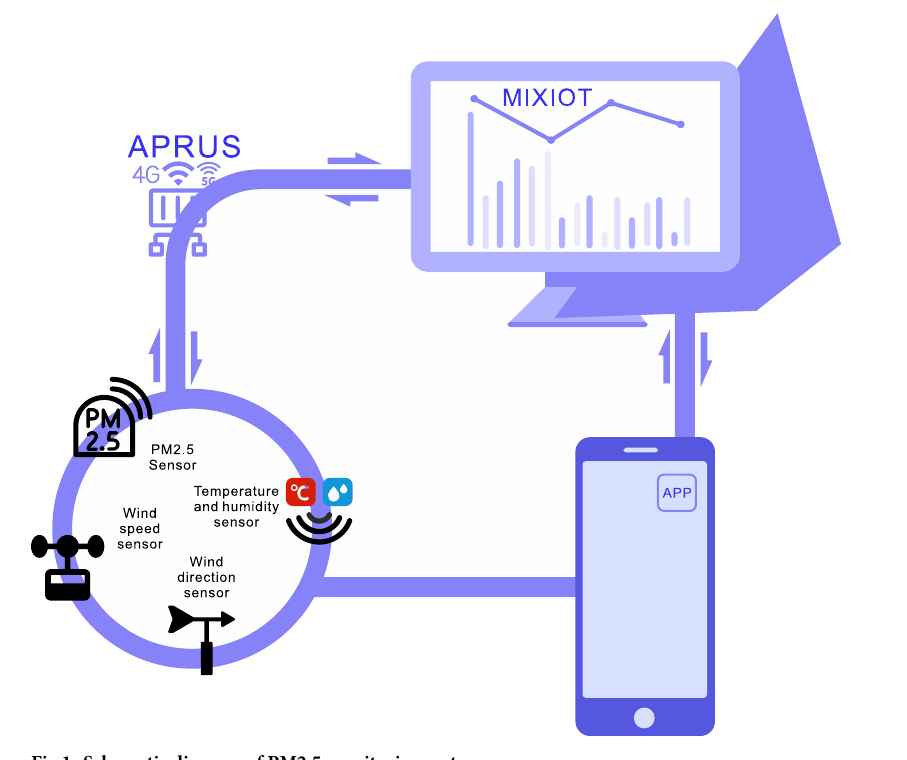
Fig 1. Schematic diagram of PM2.5 monitoring